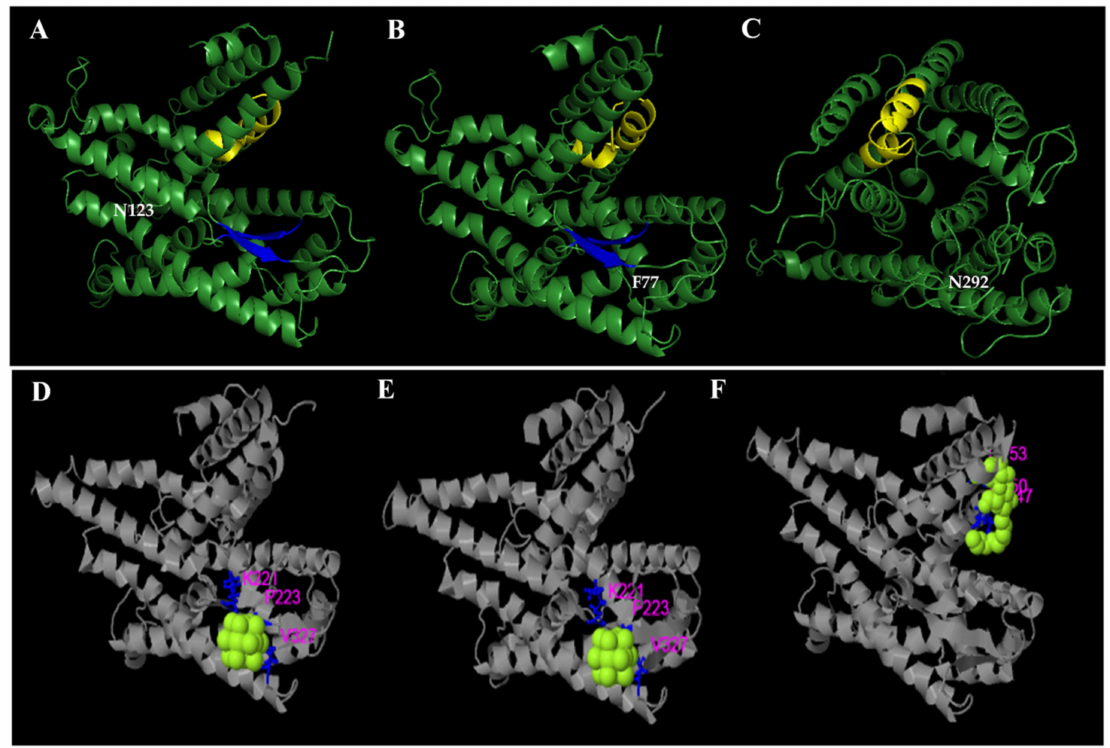
Figure 6. Structural comparison between SecY6 ( A ), SecY33 ( B ), and SecY52 ( C ) protein variants. Three-dimensional structures are modelled based on the sequence alignment with Bacillus subtilis SecY (6itc.1). Amino acid residues that differ in the strains are tagged in white. The yellow and blue colors indicate respectively the protein SecY signatures domain and the beta-sheet structure. The predicted binding ligand is highlighted in yellow-green spheres for SecY6 ( D ), SecY33 ( E ), and SecY52 ( F ), with the corresponding binding residues shown as blue ball-and-stick illustrations in the picture of the 3-D